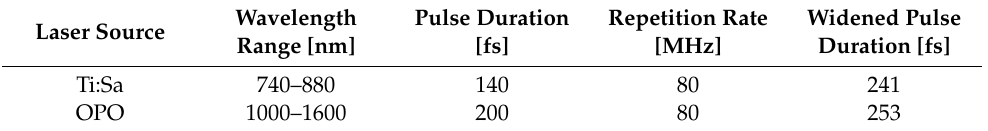
Figure 4. Autocorrelation trace of the pulsed laser sources ( a ) Ti:Sa and ( b ) OPO, respectively. Results of the Gaussian fit are also reported. Table 1. Pulsed laser sources properties. Table 1. Pulsed laser sources properties.